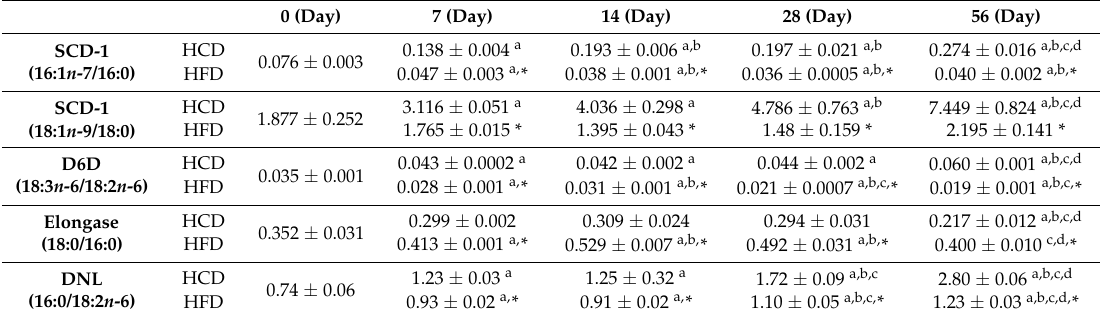
Table 4. Estimations of enzyme activities (SCD-1, D6D and elongase) and of de novo lipogenesis (DNL) in the liver from mice fed with high carbohydrate diet (HCD) or high fat diet (HFD) at 0 (before starting the diets) or after 7, 14, 28 or 56 days.